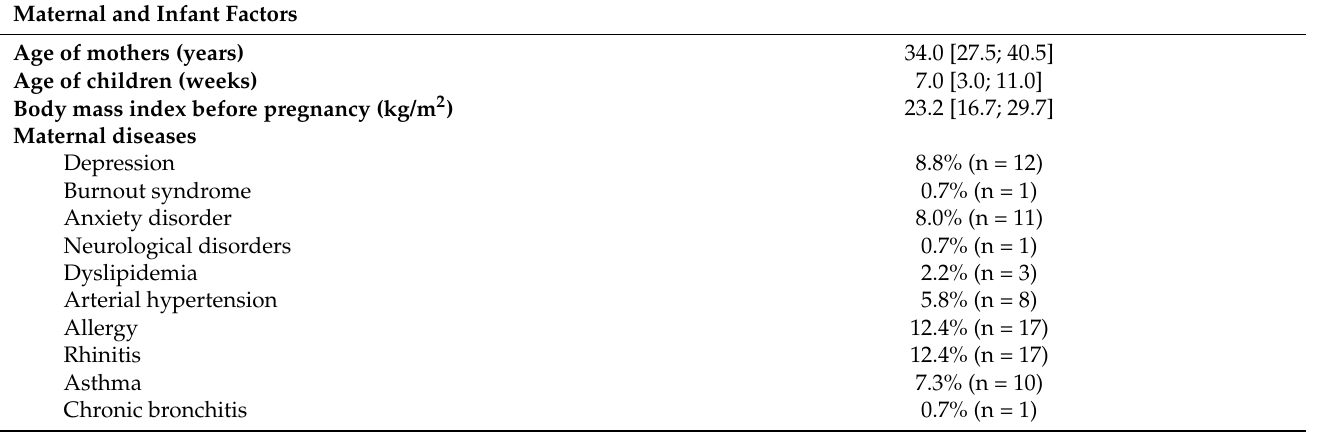
Table 1. Demographic and clinical information of the mother–child pairs. Results are shown in prevalence (% (n)) or median (interquartile